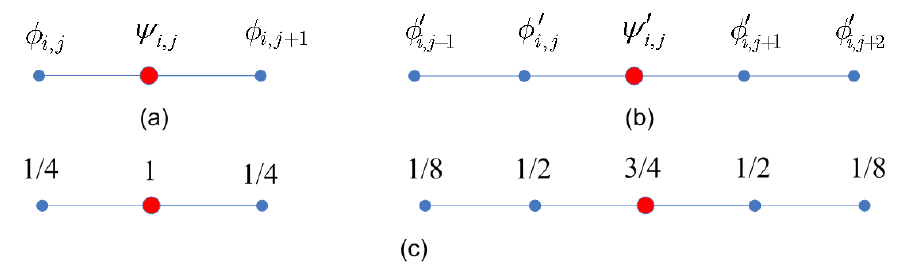
Figure 8. (a) Constructing wavelets as linear combination of lazy wavelets and scaling functions in radial layers of overlap regions; (b) Constructing wavelets as linear combination of lazy wavelets and scaling functions in circular layers of overlap regions; (c) Discrete subdivision masks of basis